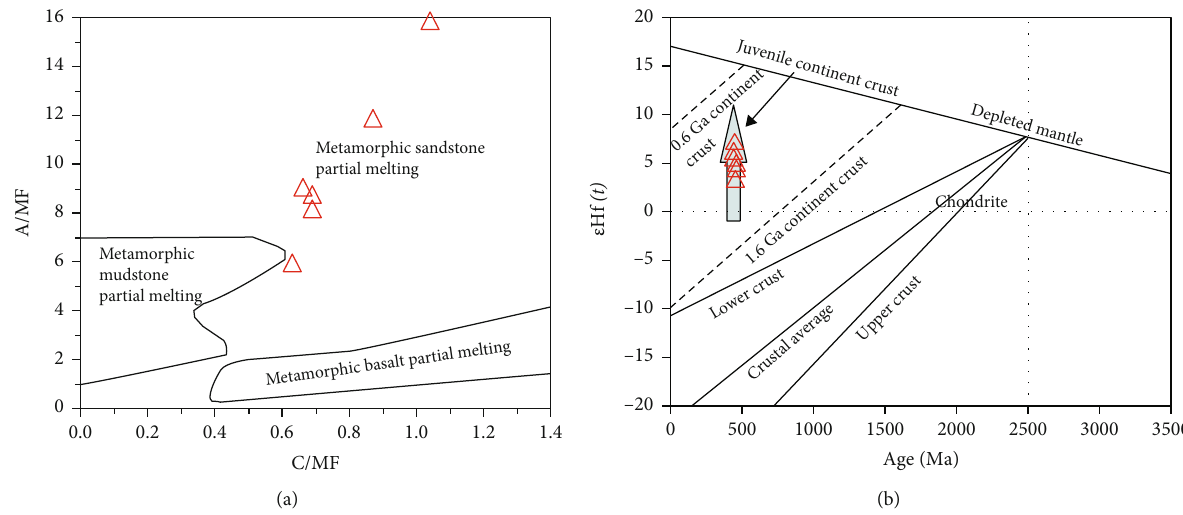
Figure 7: C/MF vs. A/MF and age (Ma) vs. ε Hf ð t Þ diagram for the Bieyesamas monzogranite (after [42]). Table 4: Values for sample by zircon saturation